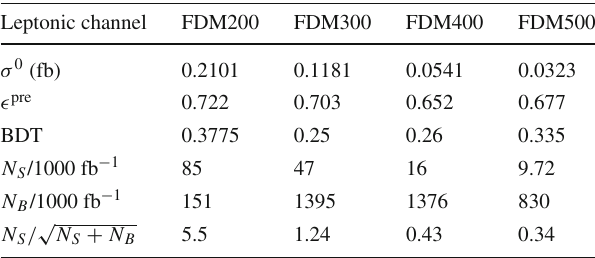
Table 6 The meaning of each row is the same as in Table 3, with the leptonic channel instead Leptonic